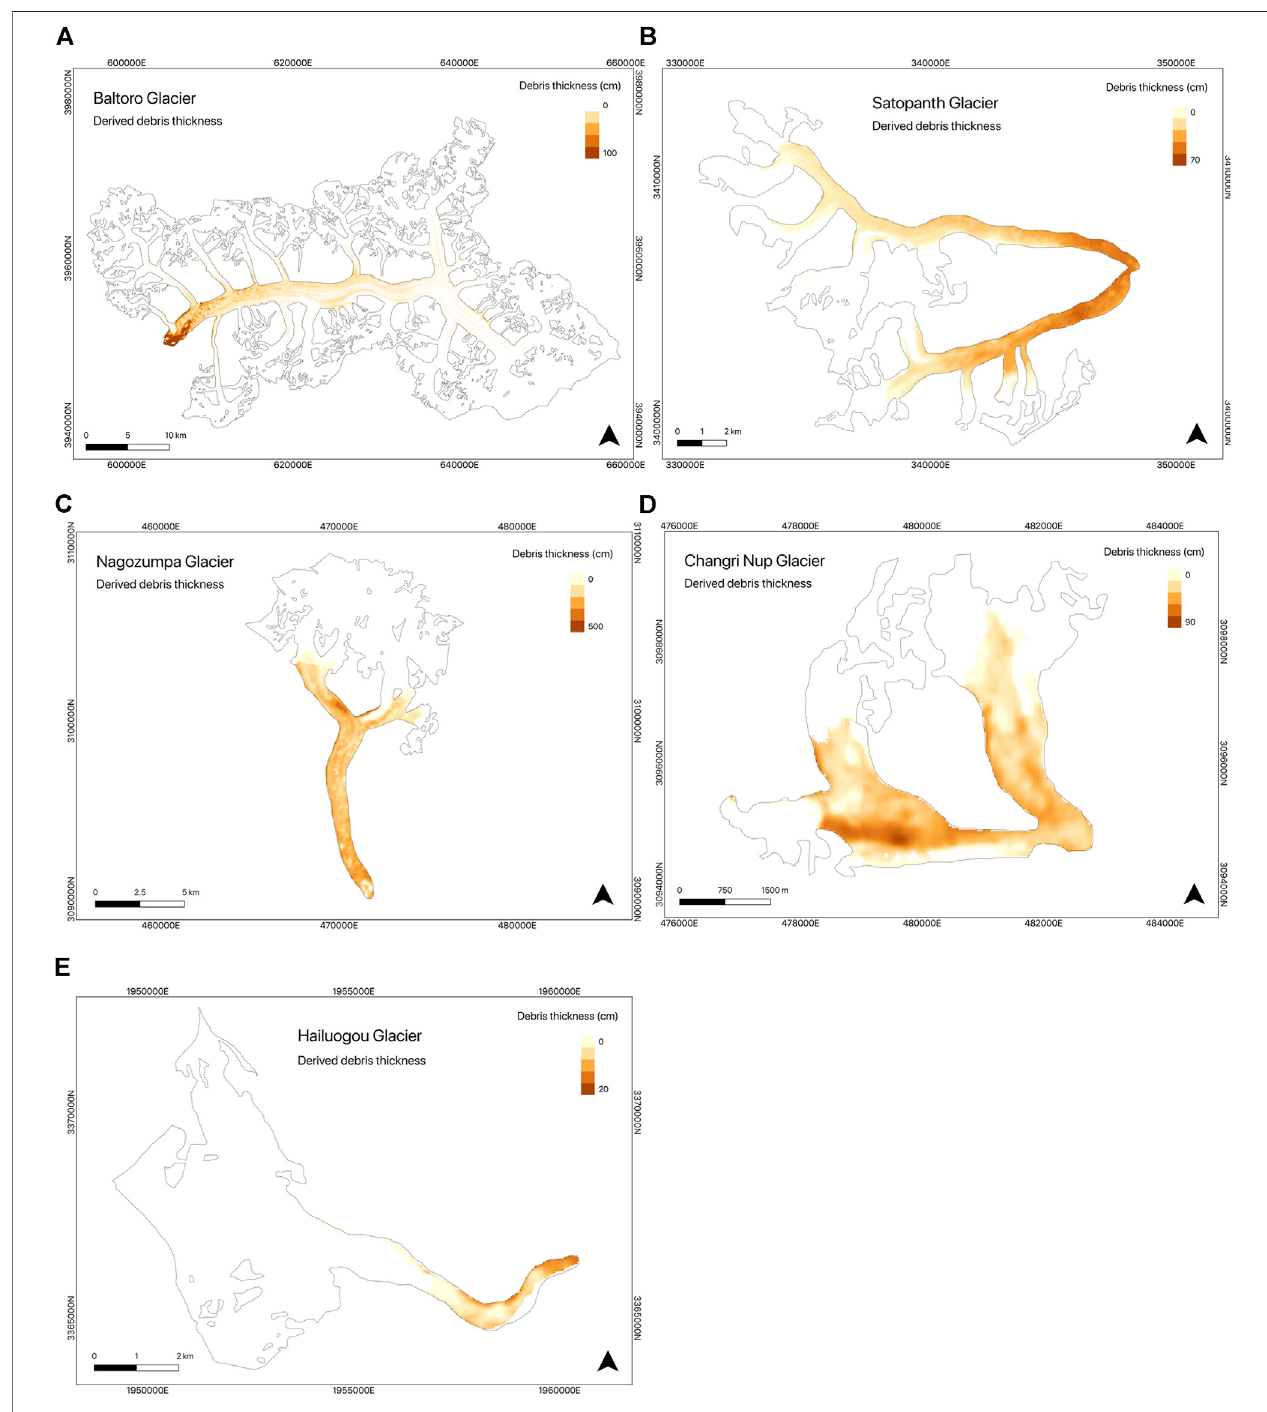
FIGURE 5 | Derived debris thickness distributions for the debris-covered parts of (A) Baltoro Glacier, (B) Satopanth Glacier, (C) Ngozumpa Glacier, (D) Changri NupGlacier,and (E) HailuogouGlacier.GlacieroutlinesareprovidedbyGAMDAM(Sakai,2019).Seenoteincaptionfor Figure2 regardingChangriNupGlacieroutline. Note that debris thickness scales vary between